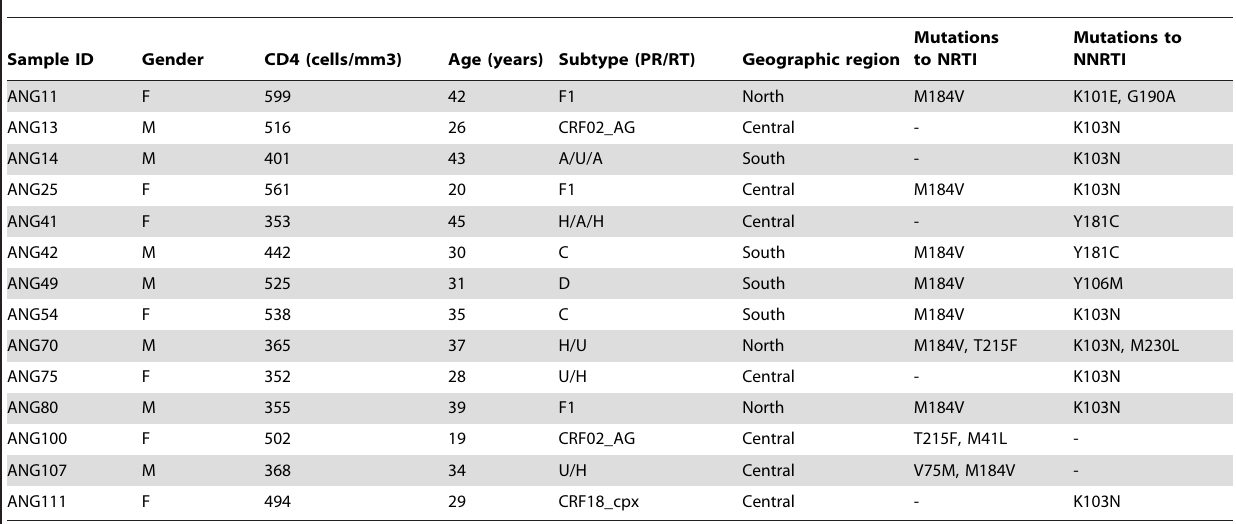
Table 2. Epidemiological, clinical and virological characteristics of Angolan treatment naı¨ve patients with primary DRM.